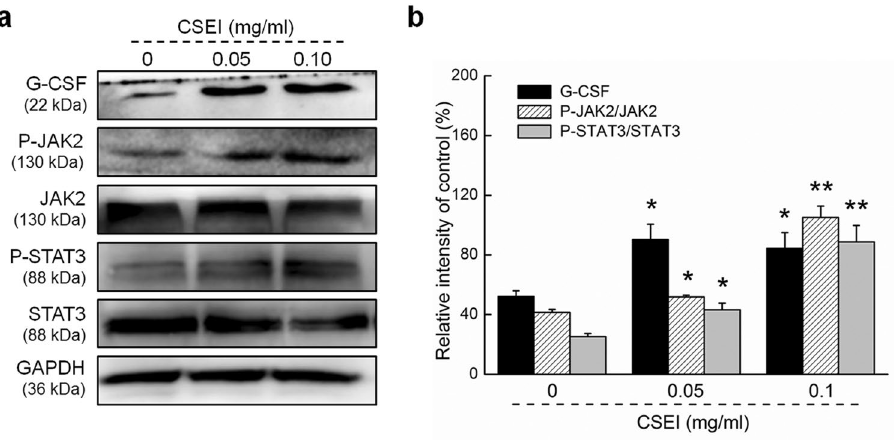
Figure 7. G-CSF-mediated JAK2/STAT3 signaling is promoted by CSEI in the primary cultured BMNCs. The BMNCs were seeded and co-cultured with CSEI (0, 0.05, 0.1 mg/ml) for 24 h. ( a ) The protein expression levels of G-CSF, JAK2, P-JAK2, STAT3, and P-STAT3 were analyzed by western blotting. ( b ) The protein levels were normalized by the corresponding GAPDH and related total protein expressions, and expressed as the percentage of the corresponding relative intensity of the control. Full-length blots are presented in Supplementary Fig. S6b. The data are shown as the means ± S.E.M. (n = 10). * P < 0.05 and ** P < 0.01 versus 0 mg/ml CSEI-treated